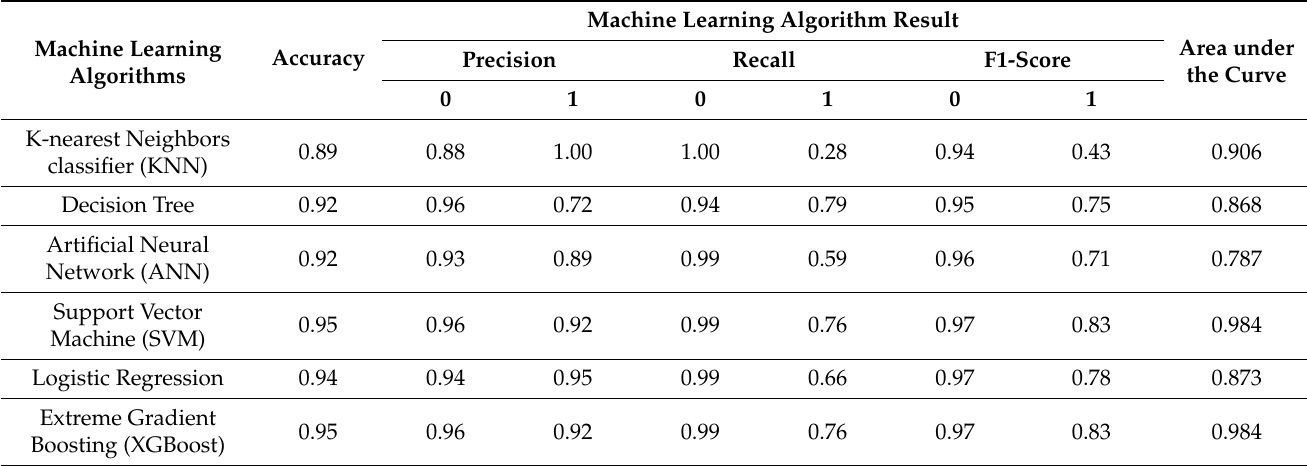
Table 3. Comparative result of the six machine learning algorithms on the UCI